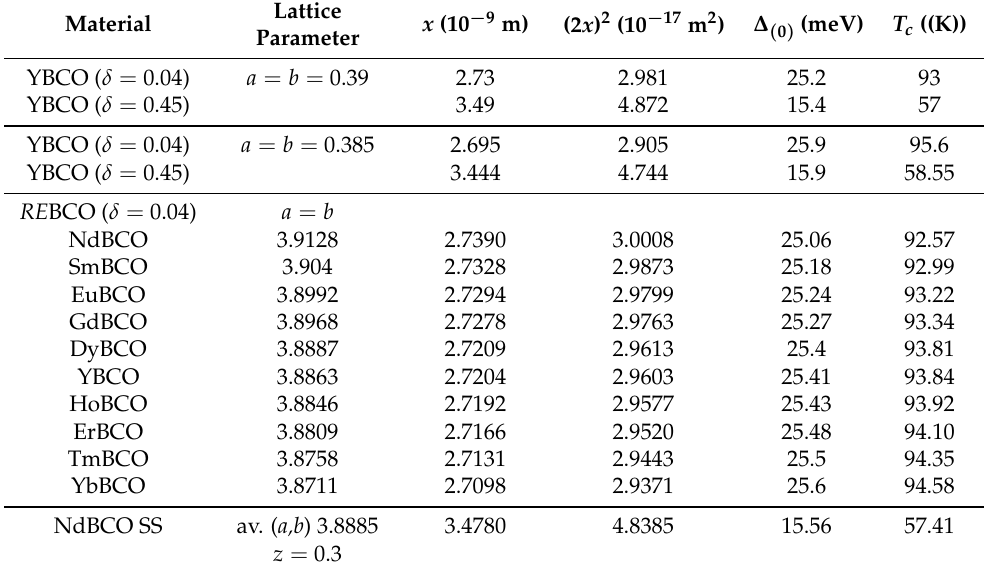
Table 1. The distance x , ( 2 x ) 2 , the calculated energies, ∆ ( 0 ) , and the calculated T c using the a -axis (data of Figure 5) for the various RE BCO materials. The data for YBCO in the first two rows are the data from Ref. [9] with a = b , and the next two rows use a = 0.385 nm as the optimum found in [37]. All T c -data correspond well to the data obtained on bulk samples; in the case of thin films as discussed in Ref. [38], the correlation is not so straightforward. NdBCO-SS is discussed in Section 3.4 below. Lattice Material